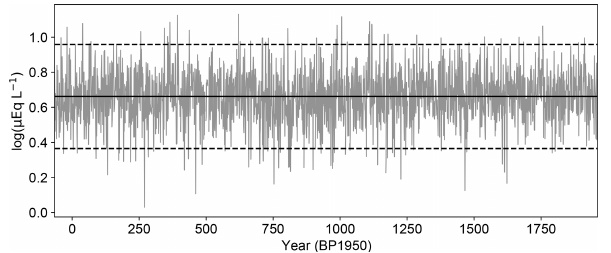
Figure 17. Time series for JJASON (cool season) annual sea salts concentration. Solid black line indicates the 2000-year mean value. Dashed black lines indicate ± 2 σ values.